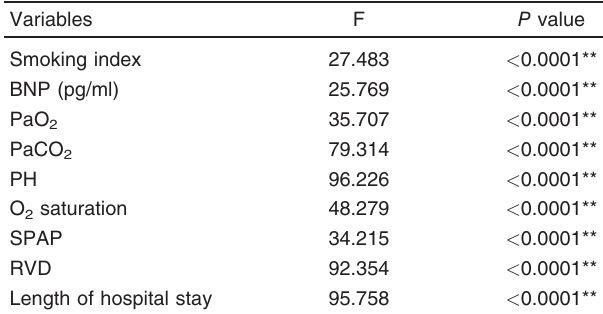
Table 5 Significant predictors of ICU admission in acute exacerbation of chronic obstructive pulmonary disease patients using univariate analysis ( n =